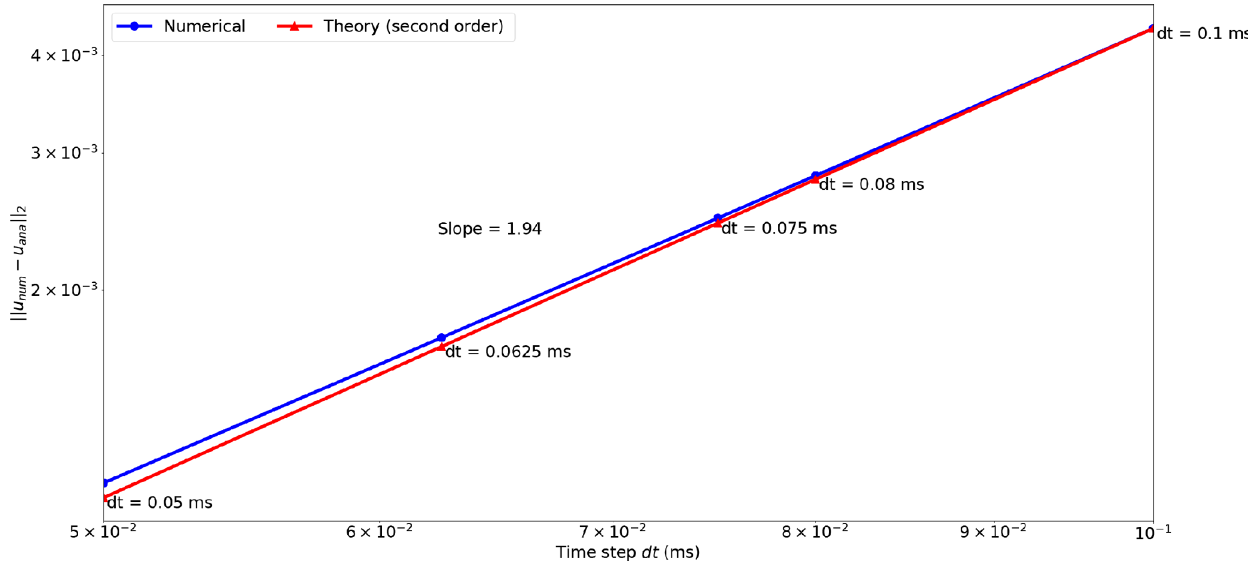
Figure 10. Time discretization convergence analysis for a fixed grid, fixed propagation time (150ms), and varying time step values. The result is plotted in a logarithmic scale and the numerical convergence rate (1.94 slope) shows that the numerical solution is accurate.